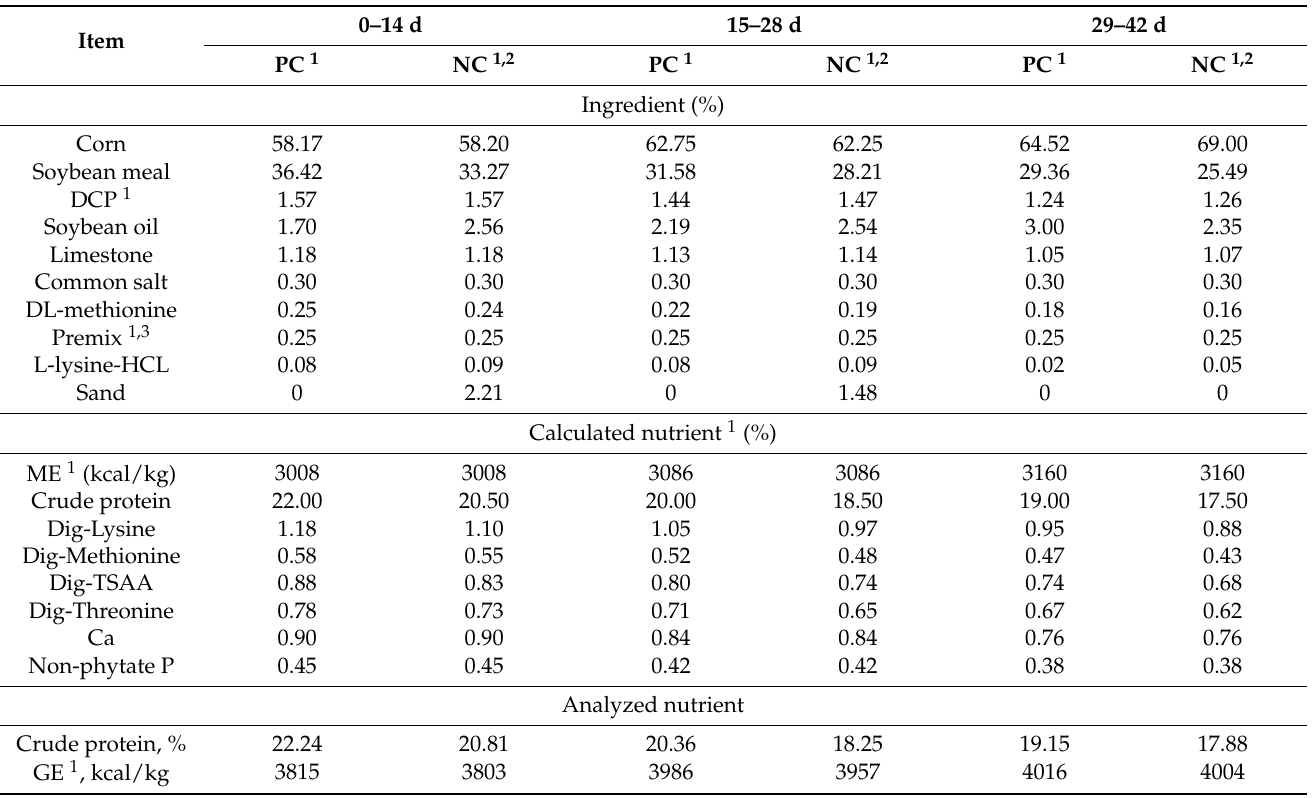
Table 1. Feed formulation and composition of the experimental